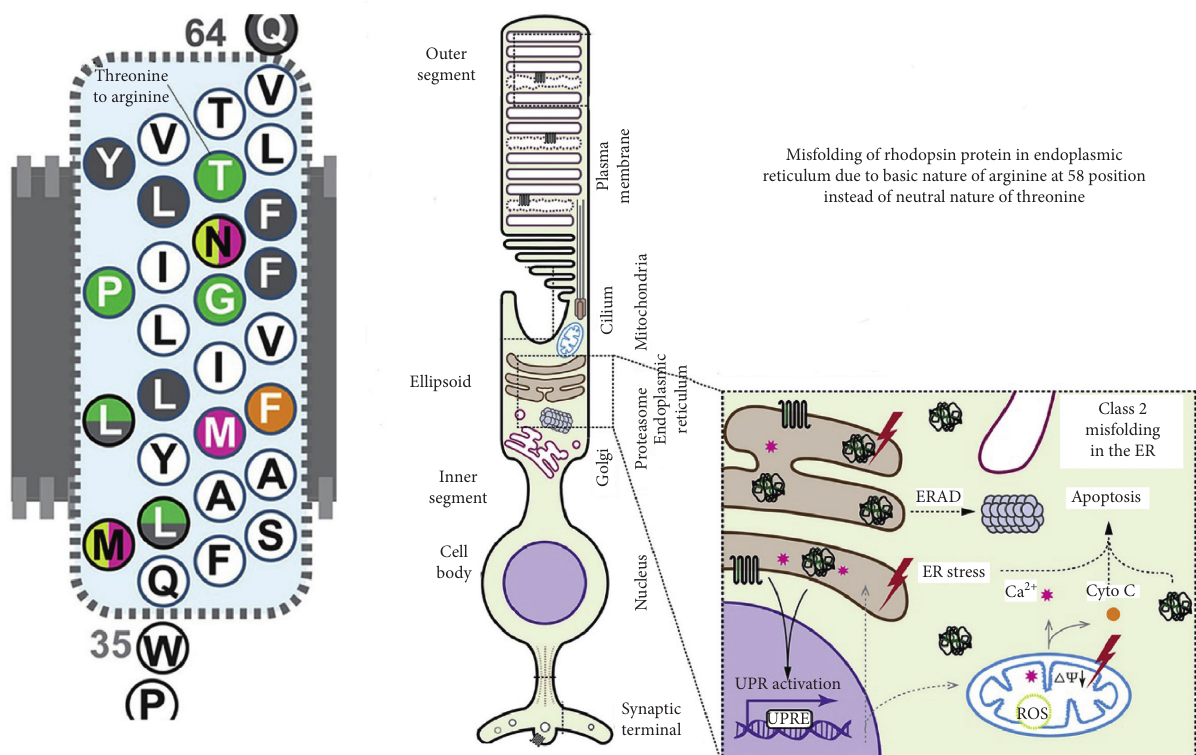
Figure 7: Threonine to arginine replacement is noted at position 58; cartoon documenting the pathobiology including misfolding of rhodopsin with accumulation in the endoplasmic reticulum and subsequent apoptosis of photoreceptor